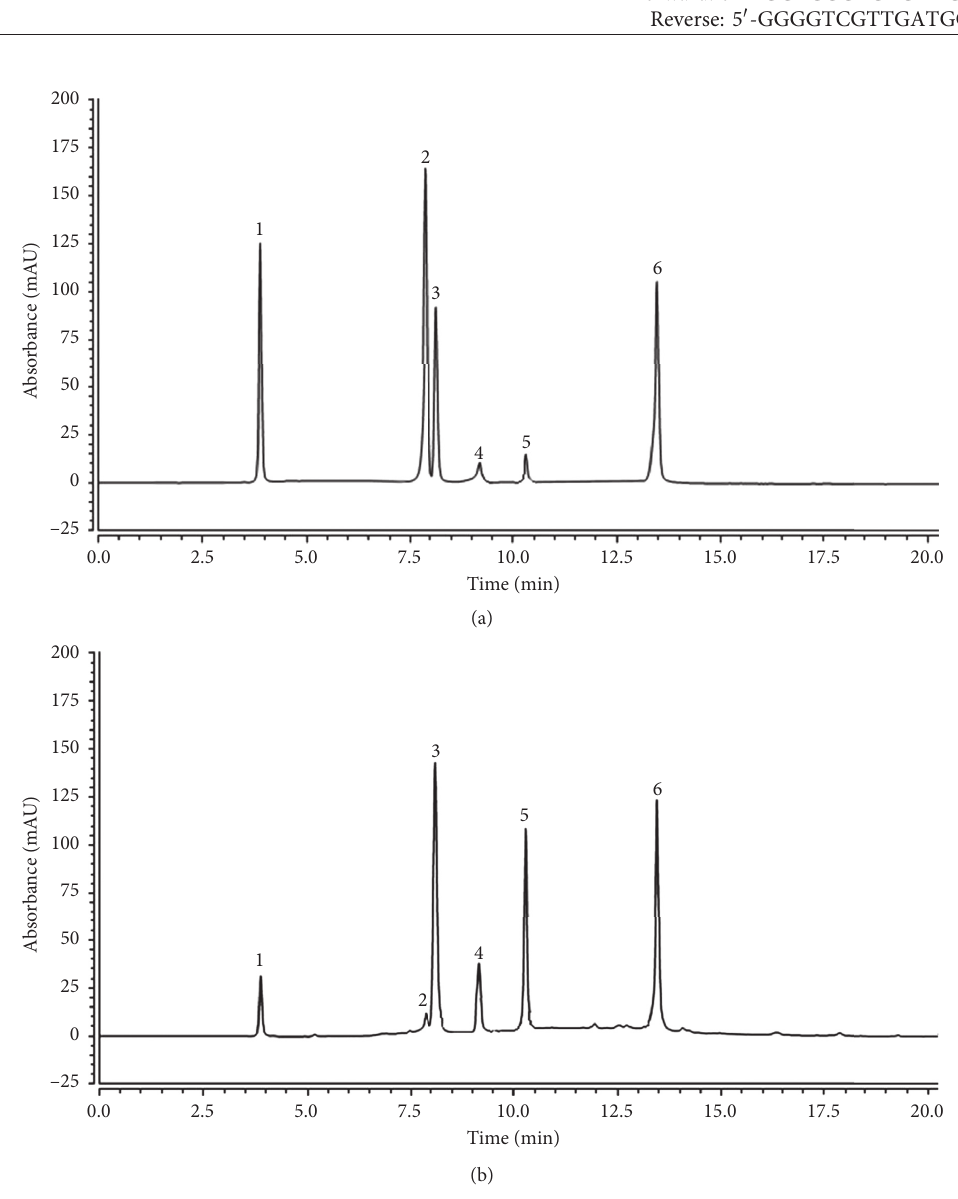
Figure 1: Polyphenol constituents of Liupao tea. (a) Standard chromatograms. (b) Polyphenols of Liupao tea chromatograms.1: gallic acid; 2: catechin; 3: caffeine; 4: epicatechin; 5: epigallocatechin gallate; 6: epicatechin